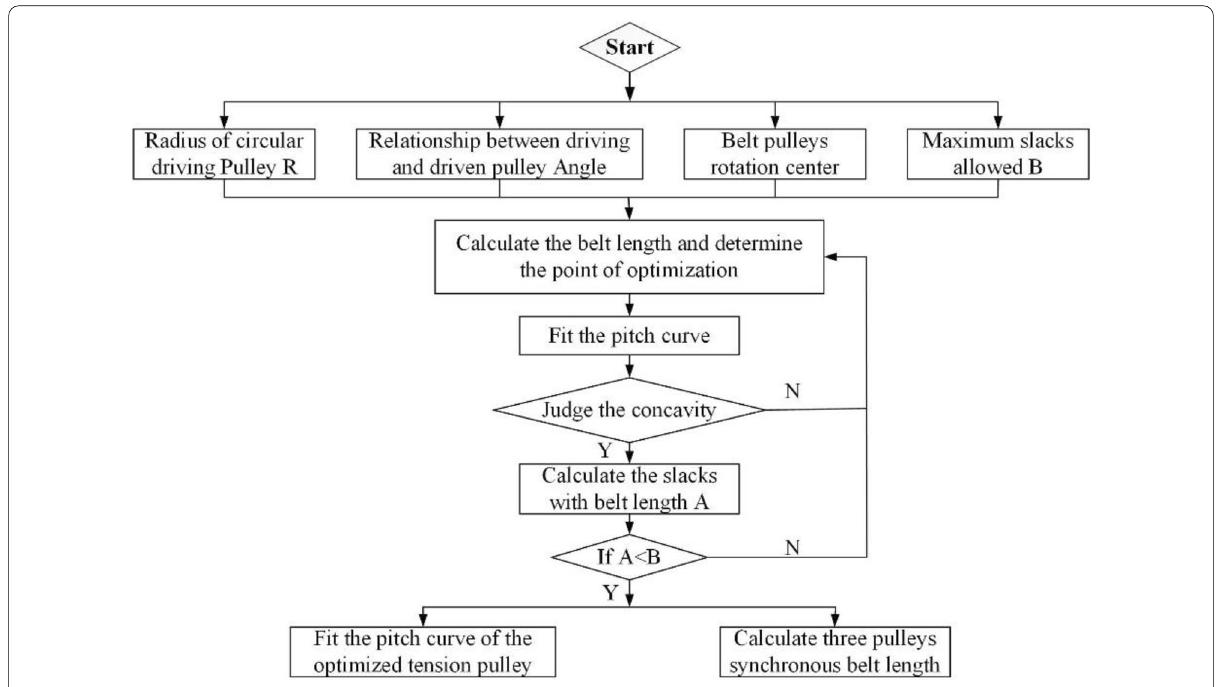
Figure 8 Flow chart of automatic optimization